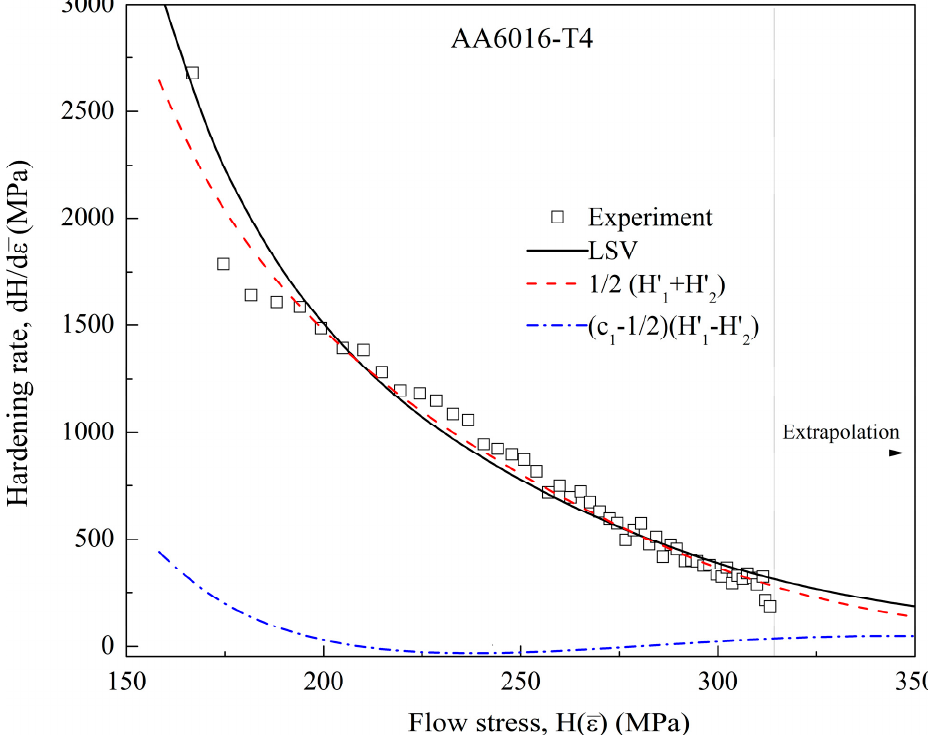
Figure 2. Application of a linear combined Swift and Voce models for AA6016-T4 sheets. Experimen- tal data after